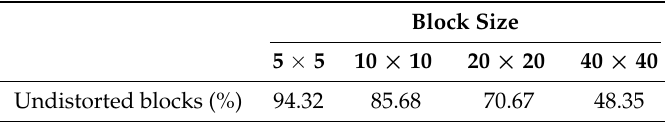
Table 2. Average percentage of undistorted blocks after